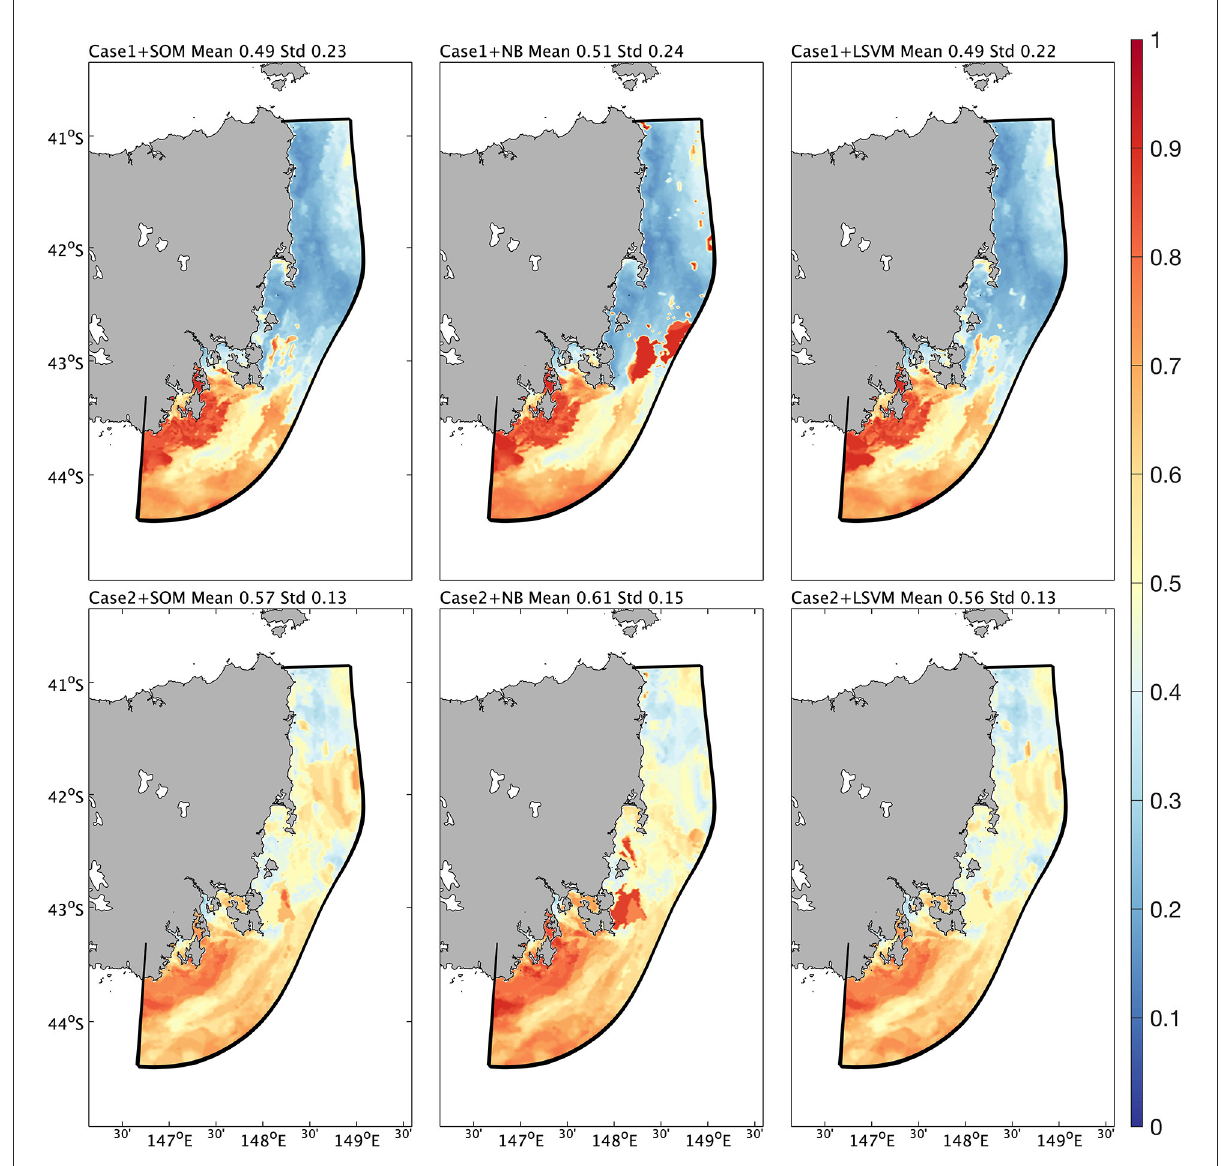
FIGURE12 Spatial precision in each experiment. Each panel is labelled as “CaseN + cluster method”, in which N corresponds to 1 or 2, and cluster method corresponds to SOM, NB, or SVM. The spatial mean and standard deviation are also labelled in the title of each panel.